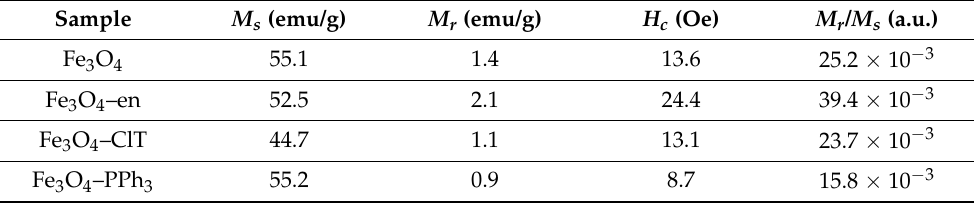
Figure 3. Magnetization curves obtained by a vibrating-sample magnetometer. The inset shows the enlarged area near the coercive field. Table 2. Magnetic properties of Fe 3 O 4 NPs (saturation magnetization ( M s ), remanence ( M r ), coercivity ( H c ), and M r / M s ratio).